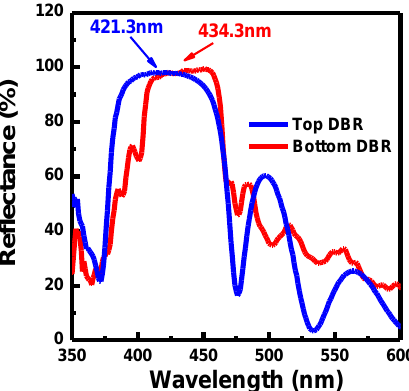
Figure 2. Reflectance spectra of top dielectric DBR and bottom porous-GaN DBR were measured at room temperature. Table 1. Top and bottom DBR structures.